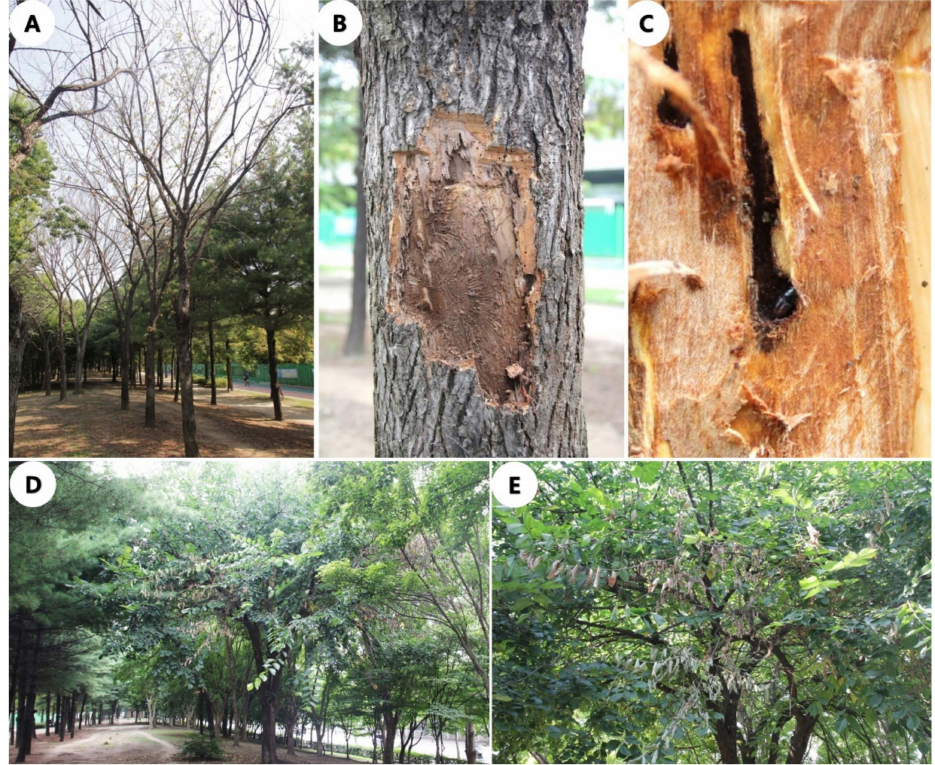
Figure 1. Symptoms associated with DED on Ulmus macrocarpa in South Korea: ( A ) dead trees; ( B ) bark beetle infestation on trunk of the tree and breeding galleries developed under the bark flap; ( C ) insect vector Scolytus jacobsoni in the breeding galleries; ( D ) dieback with yellowing and browning of leaves; ( E ) close-up view of dying